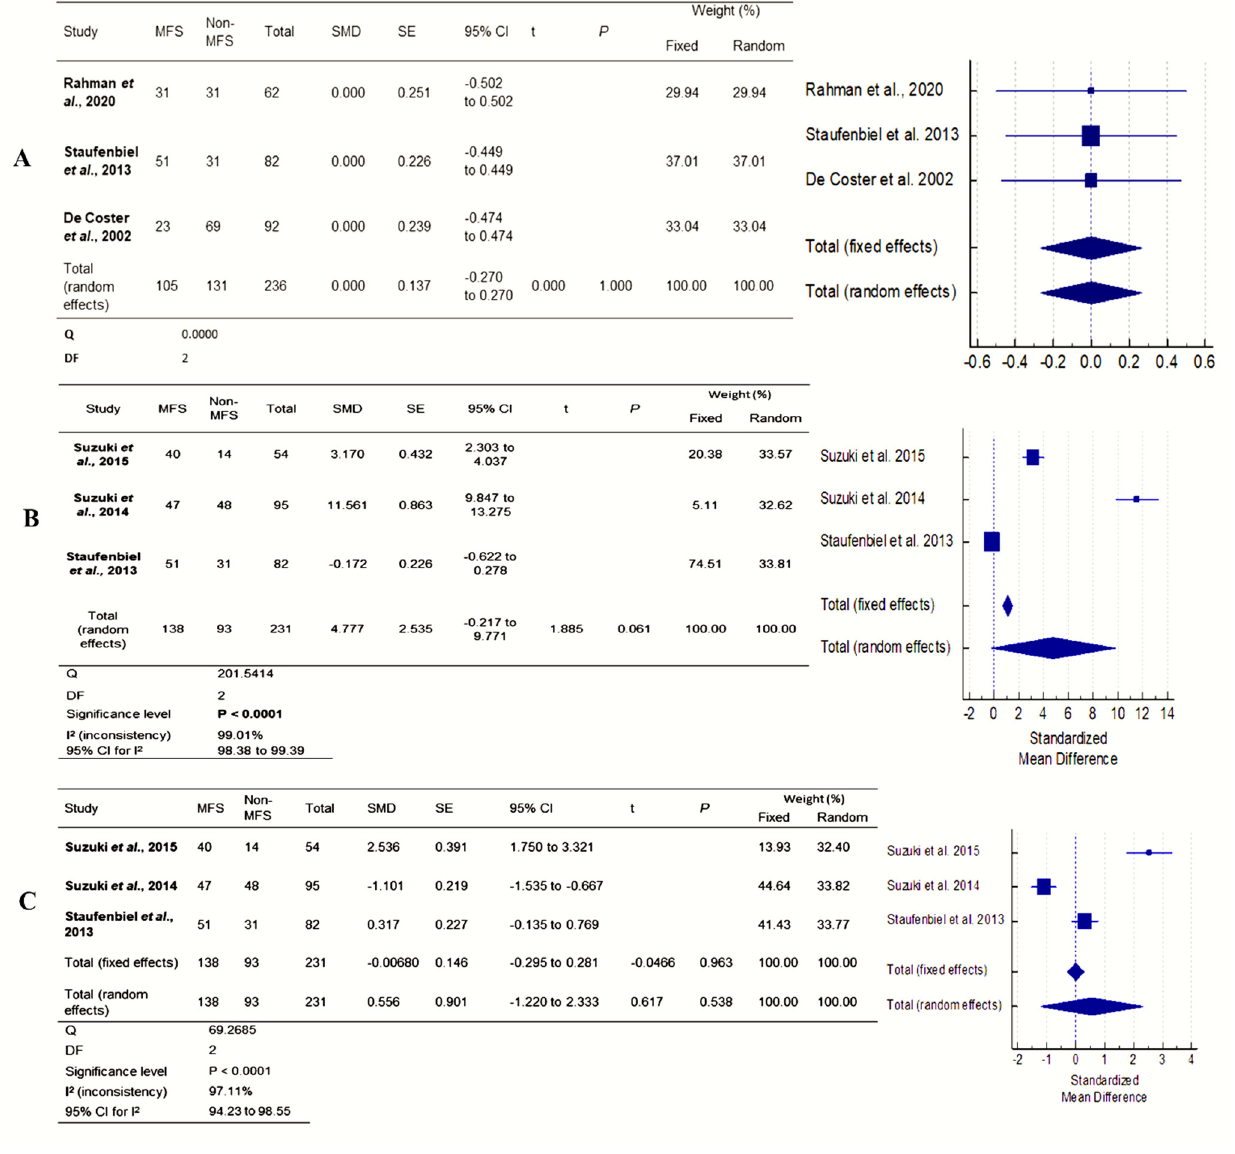
Figure 5. Forest plot of ( A ) DMFT, ( B ) pocket depth (PD), and ( C ) bleeding on probing (BOP) [8,9,17,22,23].